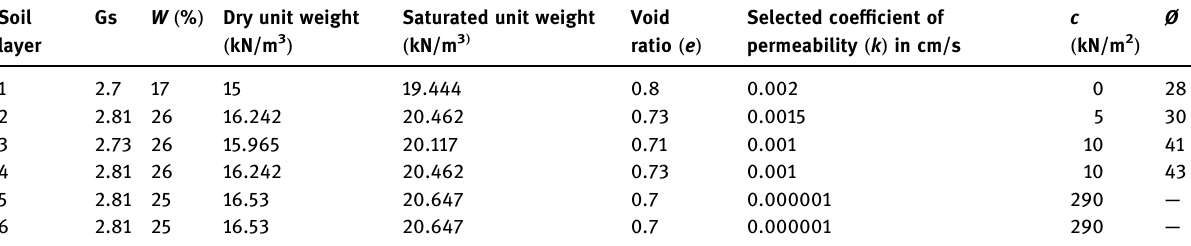
Table 2: Soil properties of the soil layers for the Al - Kufa Mosque pro fi le Soil Gs layer